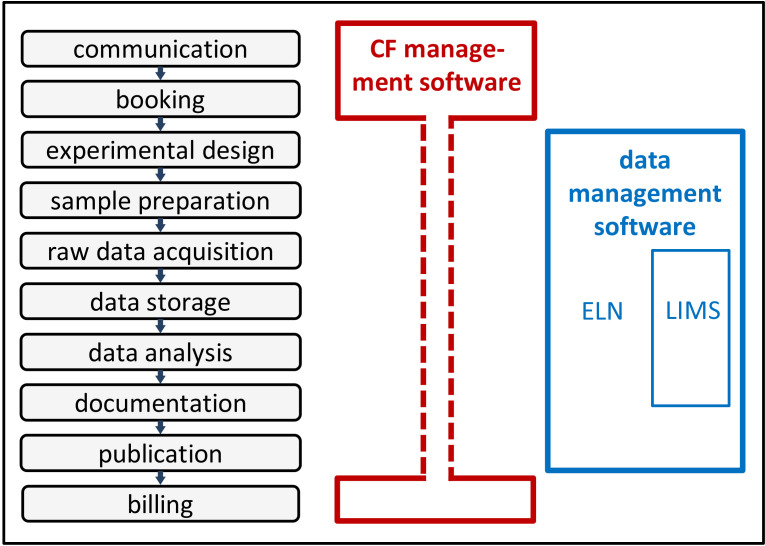
Comparison of two categories of management software used in core facilities showing the steps of the experimental process they cover.CF management software is shown in red, and data management software is shown in blue. The dashed lines indicate that some tasks are not covered or only partially covered by CF management software.